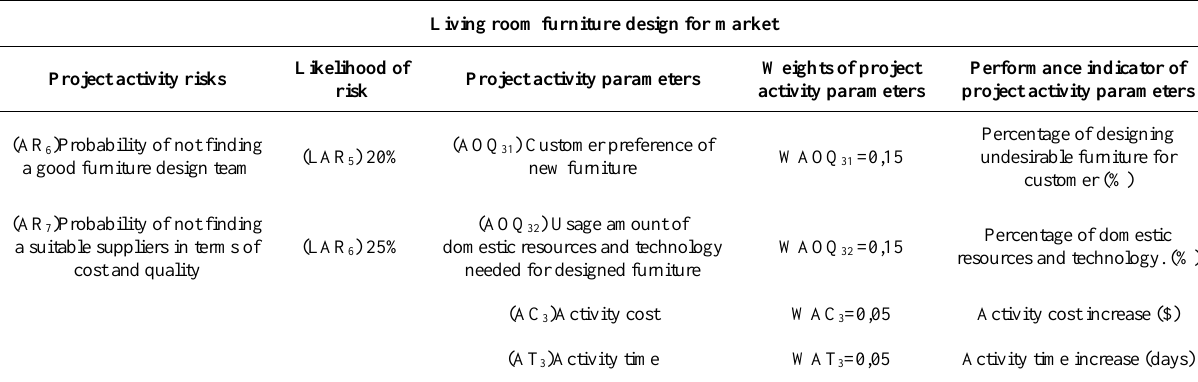
Table 4. TOPSIS table information of living room furniture design for market.